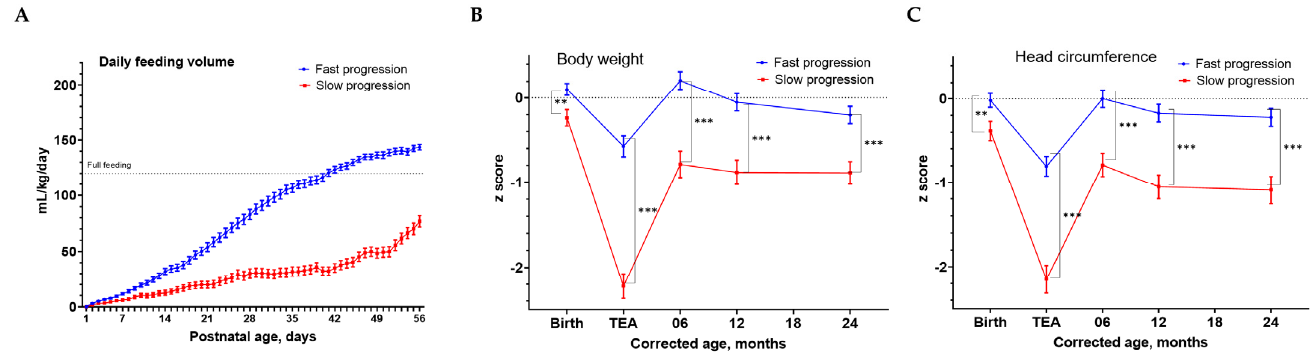
Figure 1. ( A ) Differences in the daily enteral feeding volumes in the first 56 postnatal days between the fast progression feeding pattern group and the slow progression feeding pattern group in extremely preterm infants. The statistical significances were observed from postnatal day 13 to day 56. Full feeding was defined as 120 mL/kg/days. Data were presented as mean ± SEM. Bonferroni adjustment was used for the multiple comparisons between the two different feeding progression patterns at each time points. Differences in the longitudinal anthropometric z-scores of bodyweights ( B ) and head circumference ( C ) from birth, term equivalent age (TEA), 6 months, 12 months, and up to 24 months of corrected age between the fast progression and slow progression feeding pattern. The blue line represents the fast progression pattern and the red line represents the slow progression pattern. Data were presented as mean ± SEM. Statistical significances: **: p < 0.01 and ***: p <0.001.